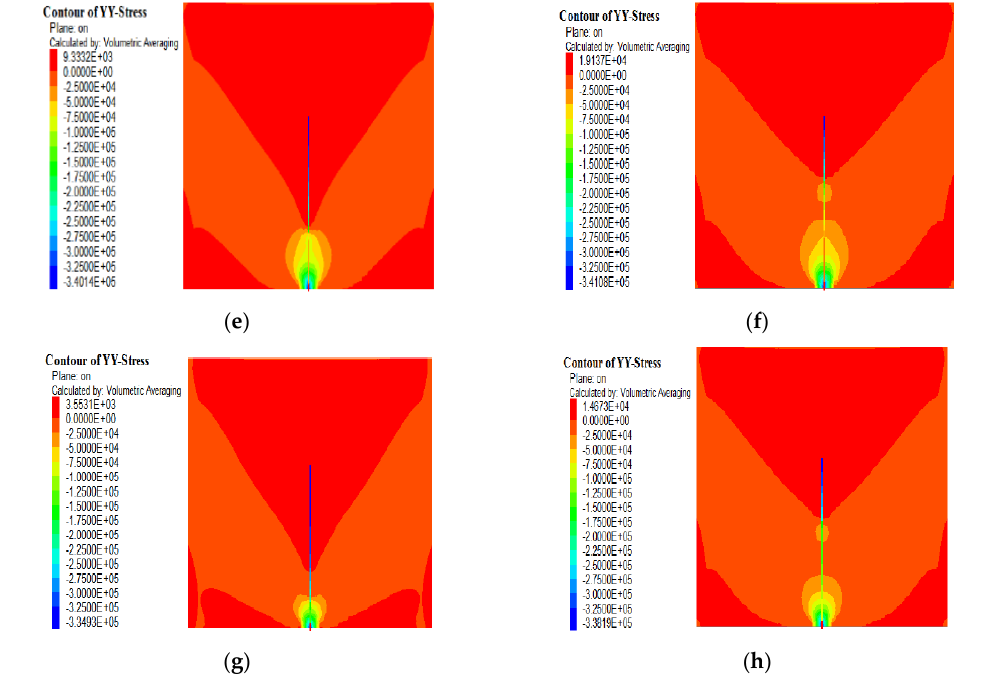
Figure 15. Stress distribution of the surrounding rock at different anchorage lengths under an initial preload of 60 kN. ( a ) With the traditional prestressed anchoring method at an anchorage length of 0.9 m; ( b ) with full stress anchoring method at an anchorage length of 0.9 m; ( c ) with the traditional prestressed anchoring method at an anchorage length of 1.3 m; ( d ) with full stress anchoring method at an anchorage length of 1.3 m; ( e ) with the traditional prestressed anchoring method at an anchorage length of 1.7 m; ( f ) with full stress anchoring method at an anchorage length of 1.7 m; ( g ) with the traditional prestressed anchoring method at an anchorage length of 2.1 m; ( h ) with full stress anchoring method at an anchorage length of 2.1